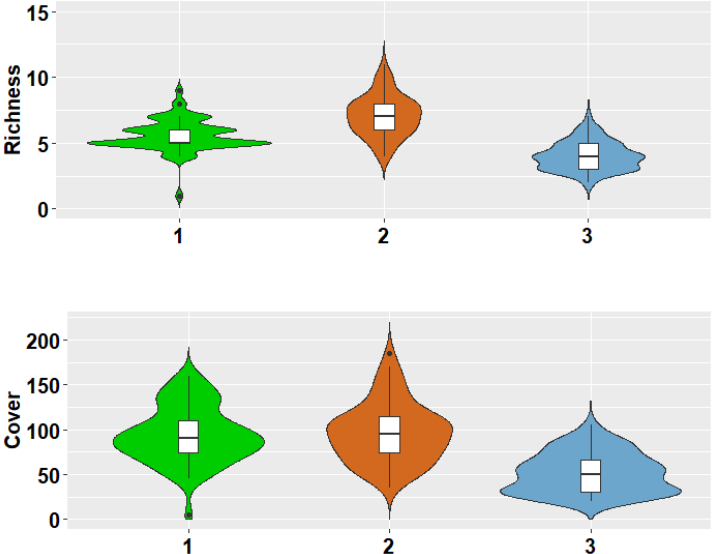
Figure 4. Violin diagram of species richness and cover in three elevations. In each violin diagram, a box plot showing the distribution of the data can be observed, followed by a thin line representing the confidence interval, while the width of the graph indicates the frequency of the species in each elevation.